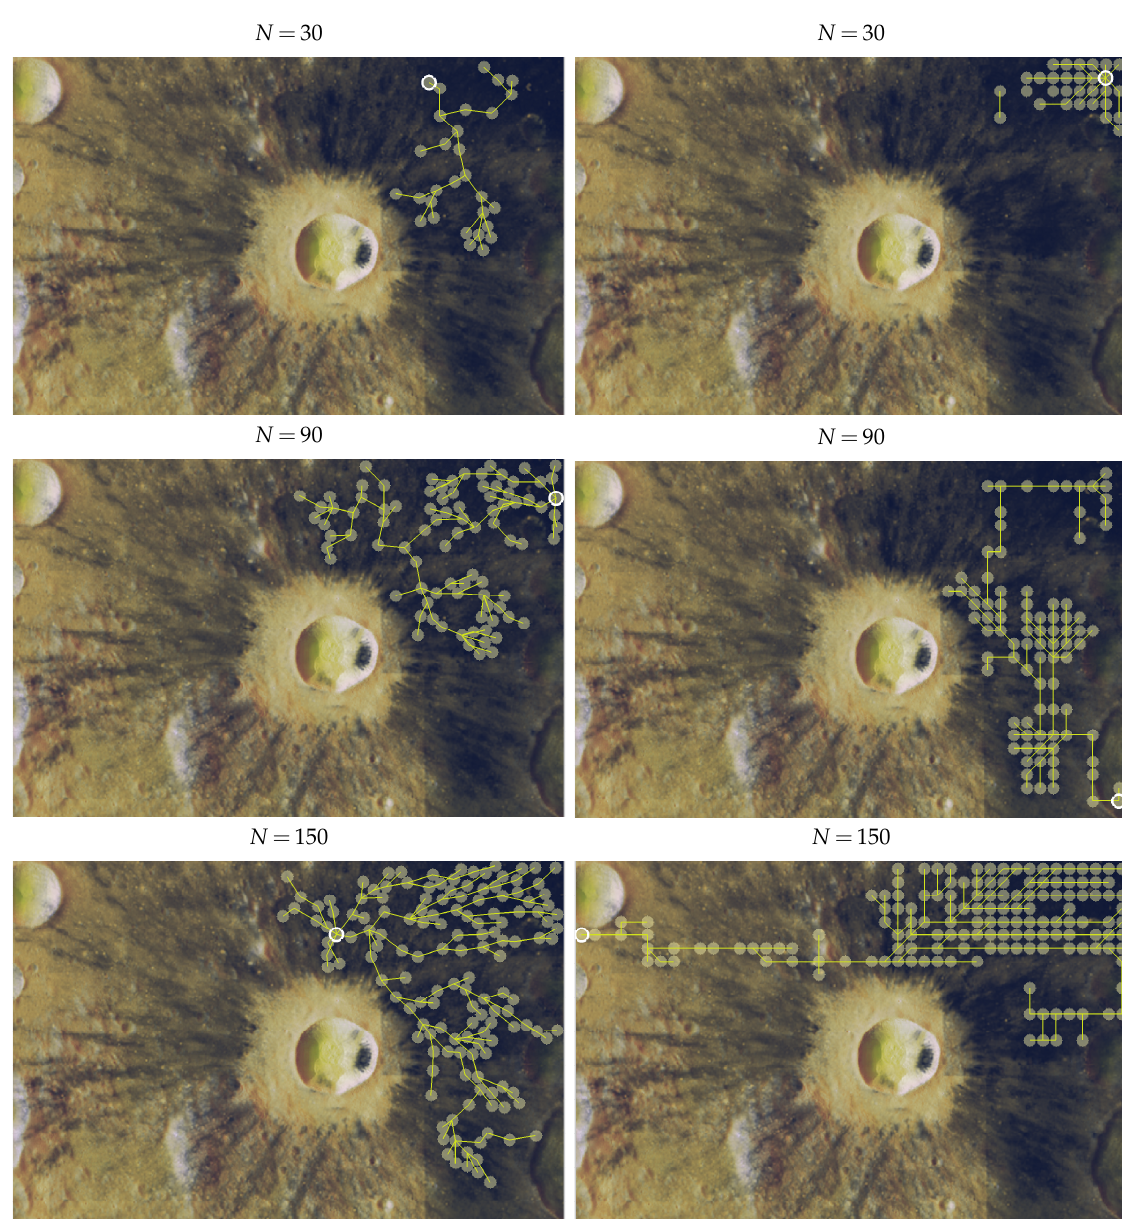
Figure 9. Node placement examples for different numbers of nodes in the Dionysius region. ACO R (left) and FDP (right). Numerical results in Table